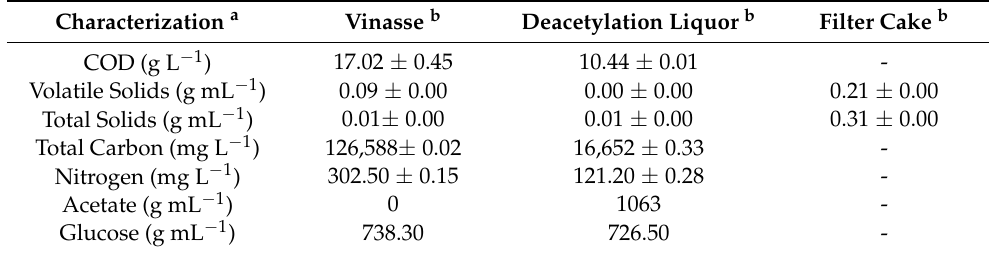
Table 1. Main characteristics of the substrates used in the two reactor